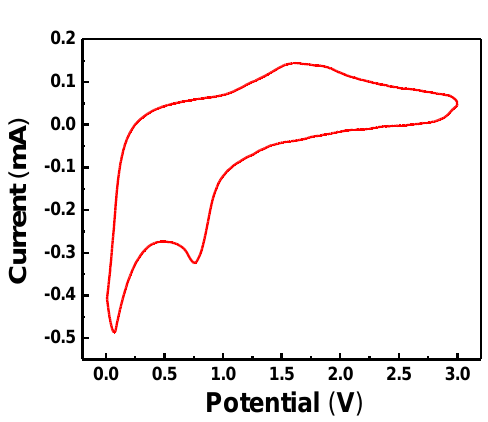
Figure 8. Cyclic voltammetry (CV) curve of the C@Fe 2 O 3 composite at the initial cycle.